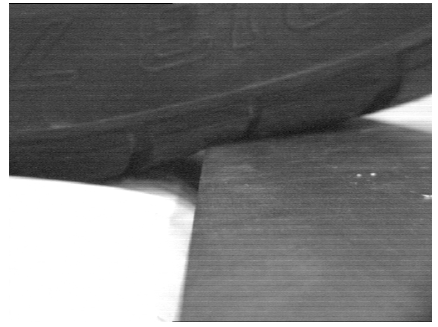
Figure 30. Tire support on a curb.